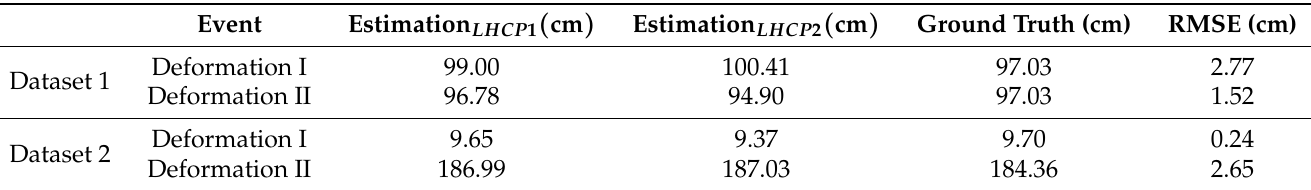
Figure 17. Zoomed extraced phase results for Deformation I in datatset 1 ( a ) LHCP1 observation ( b ) LHCP2 observation. Table 6. Deformation estimation results for both